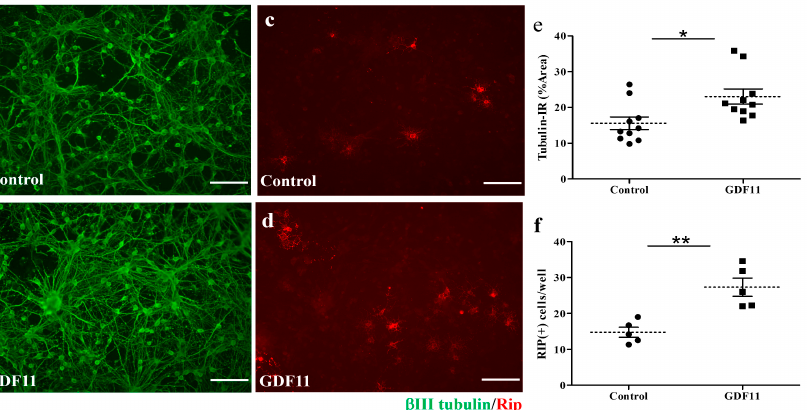
Figure 2. Effect of GDF11 on neuronal or oligodendroglial survivals in neuron–glial cultures. ( a , c ) Control cells; ( b , d ) GDF11-treated cells. Cells in ( a , b ) are β III tubulin-immunoreactive (IR) neuronal cells. Cells in ( c , d ) are Rip-IR oligodendroglial cells. ( e ) Quantification of β III tubulin-IR cell density in cultures of ( a , b ) per 0.00356 cm 2 . ( f ) Quantification of RIP-IR cell numbers in cultures of ( c , d ) per 0.00356 cm 2 . The results are reported as mean ± SEM in each group. * p < 0.05, ** p < 0.01 Control versus GDF11 treatment by unpaired Student t -test. Magnification: 200×. Scale bar: 100 μ m.